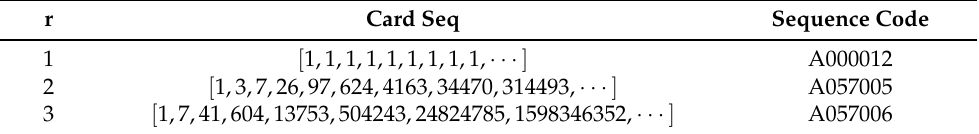
Table 1. Number of conjugacy classes of subgroups of index d in free group of rank r = 1 to 3 [11]. The last column is the index of the sequence in the on-line encyclopedia of integer sequences [12]. Card Seq Sequence